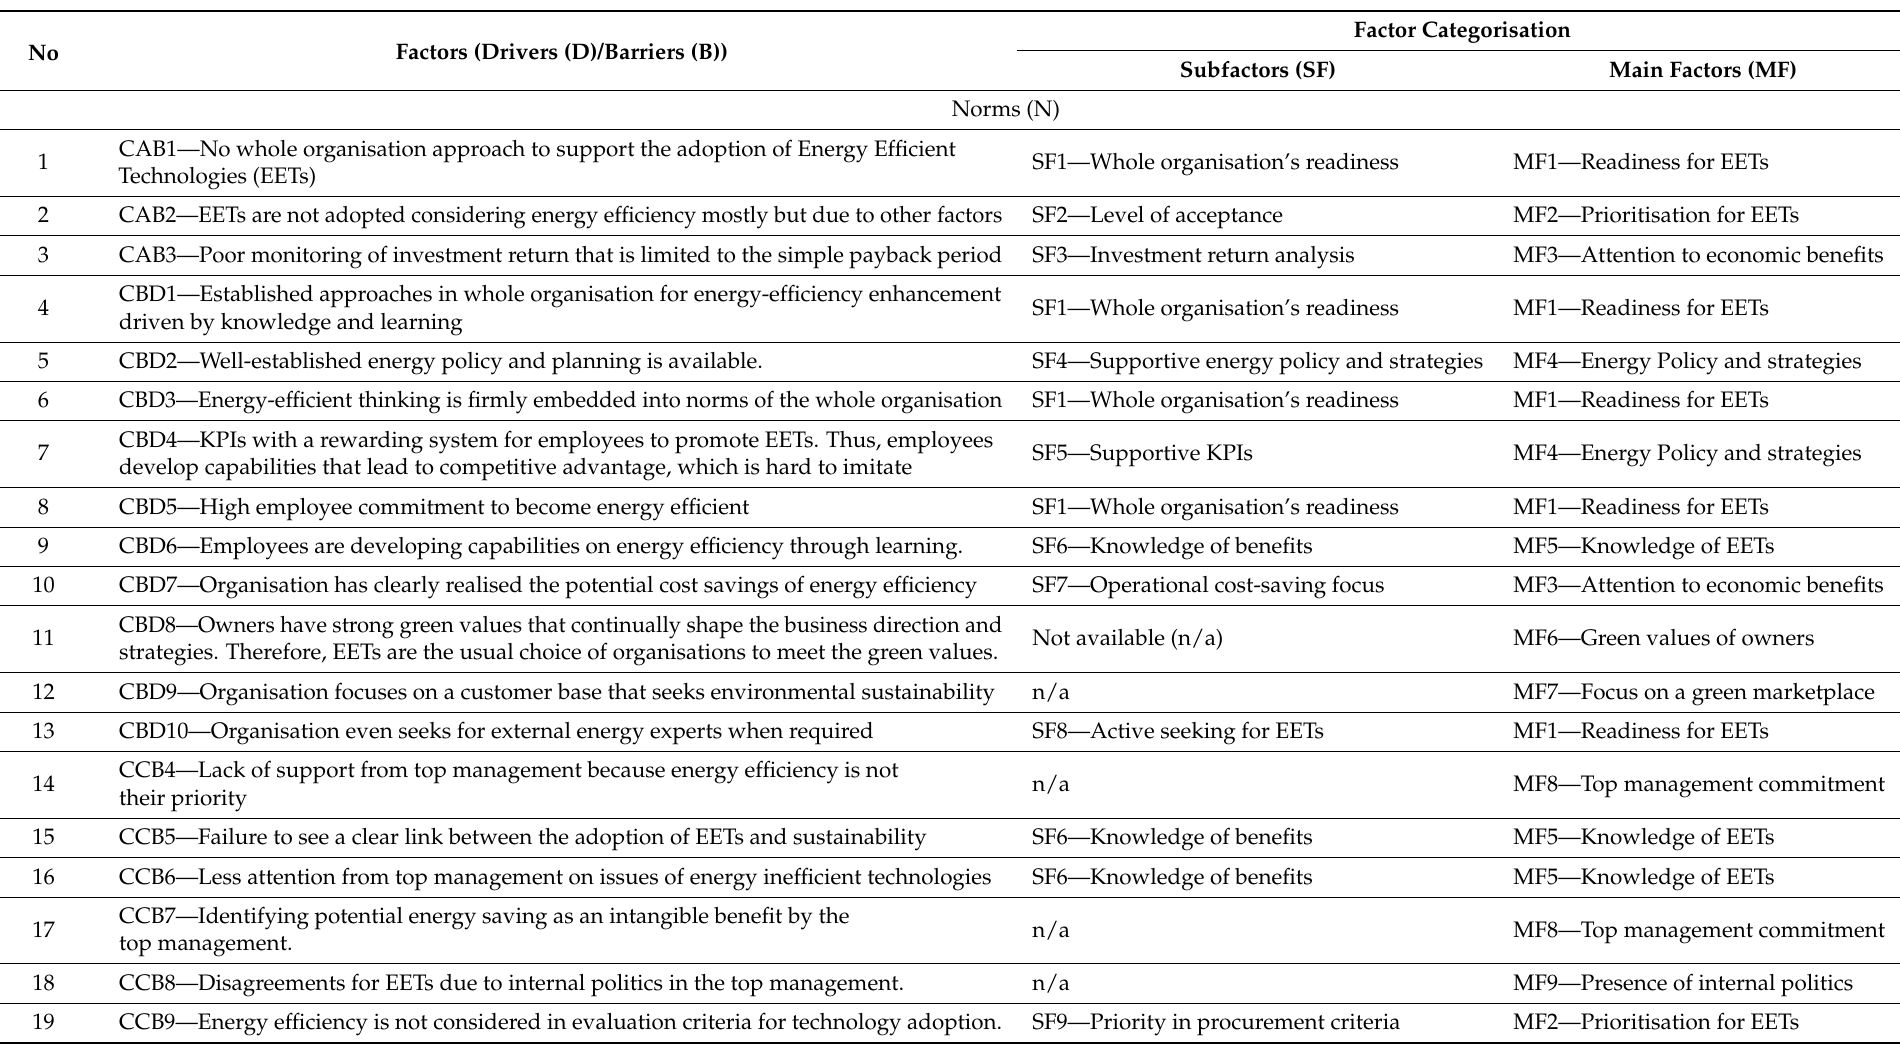
Table 5. Factors and factor